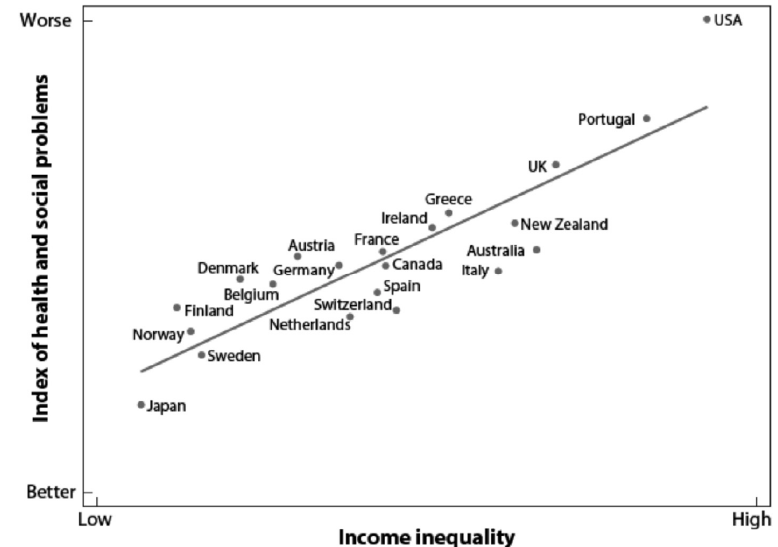
Figure 3. Relationship between income inequality versus health and social problems in wealthy countries. Income inequality is measured as the ratio of incomes between the richest 20% and poorest 20% in each country. Data are based on life expectancy, mental illness, obesity, infant mortality, teenage births, homicides, imprisonment, educational attainment, distrust and social mobility. Raw scores for each variable were converted to z-scores and each country given its average z-score. Reproduced with permission from [23]. Copyright Penguin Books, 2009.